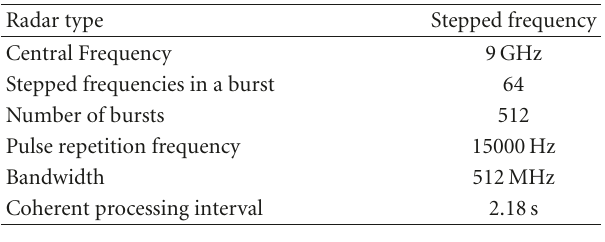
Table 1: Radar parameters for the simulated target.